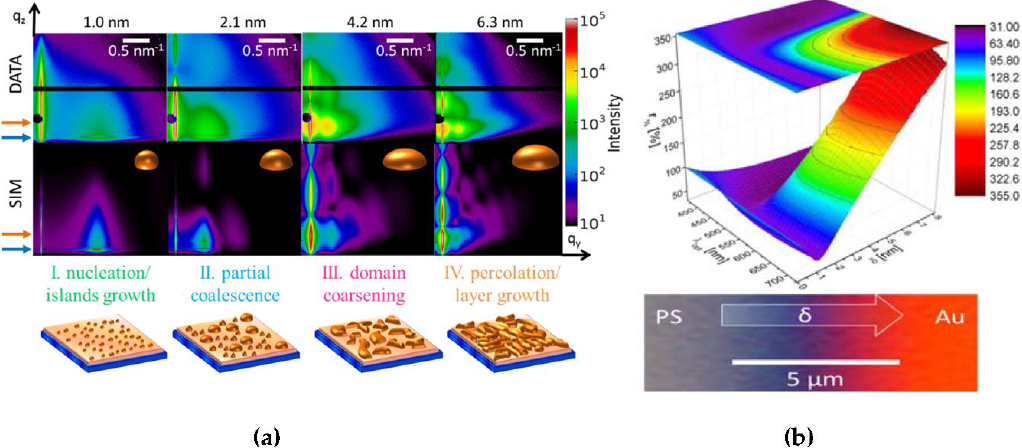
Figure 8. Sputter deposition of Au on PS. ( a ) Upper row: Selected 2D GISAXS patterns illustrate the changes in the GISAXS pattern with increasing effective Au film thicknesses δ Au . The critical angles of PS and Au are indicated by the blue and orange arrows, respectively. The beam stop to shadow the specular reflected beam is seen as the black circle, while the intermodule gap is visible as a horizontal black stripe. ( q y , q z ) denote the reciprocal space coordinate systems. Middle row: model-based simulation of the GISAXS pattern, based on the object shape sketched in the upper right corners. Lower row: Sketch of the cluster growth morphology with ongoing sputter deposition in the four regimes (I–nucleation & islands growth; II–partial coalescence; III–domain coarsening; IV–percolation & layer growth) is indicated ( b ) Change in optical reflectivity r% during the deposition process as a function of wavelength λ opt and effective thickness δ Au and optical micro-graph of a corresponding Au gradient, illustrating the change in optical reflectivity of the pristine grey-blue PS film from dark blue color due to the presence of isolated nanoclusters at the interface to bright red color stemming from larger Au aggregates. Reproduced with permission from [144]. Copyright American Chemical Society, 2015.